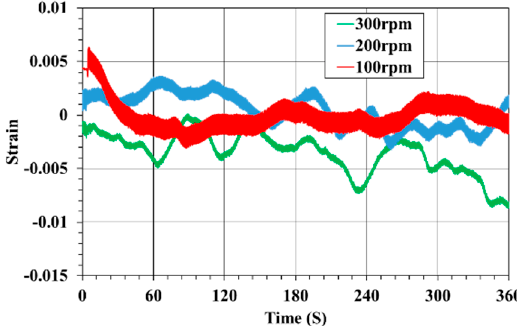
Figure 7. Experimental results of vibration measurements at a relative orientation of